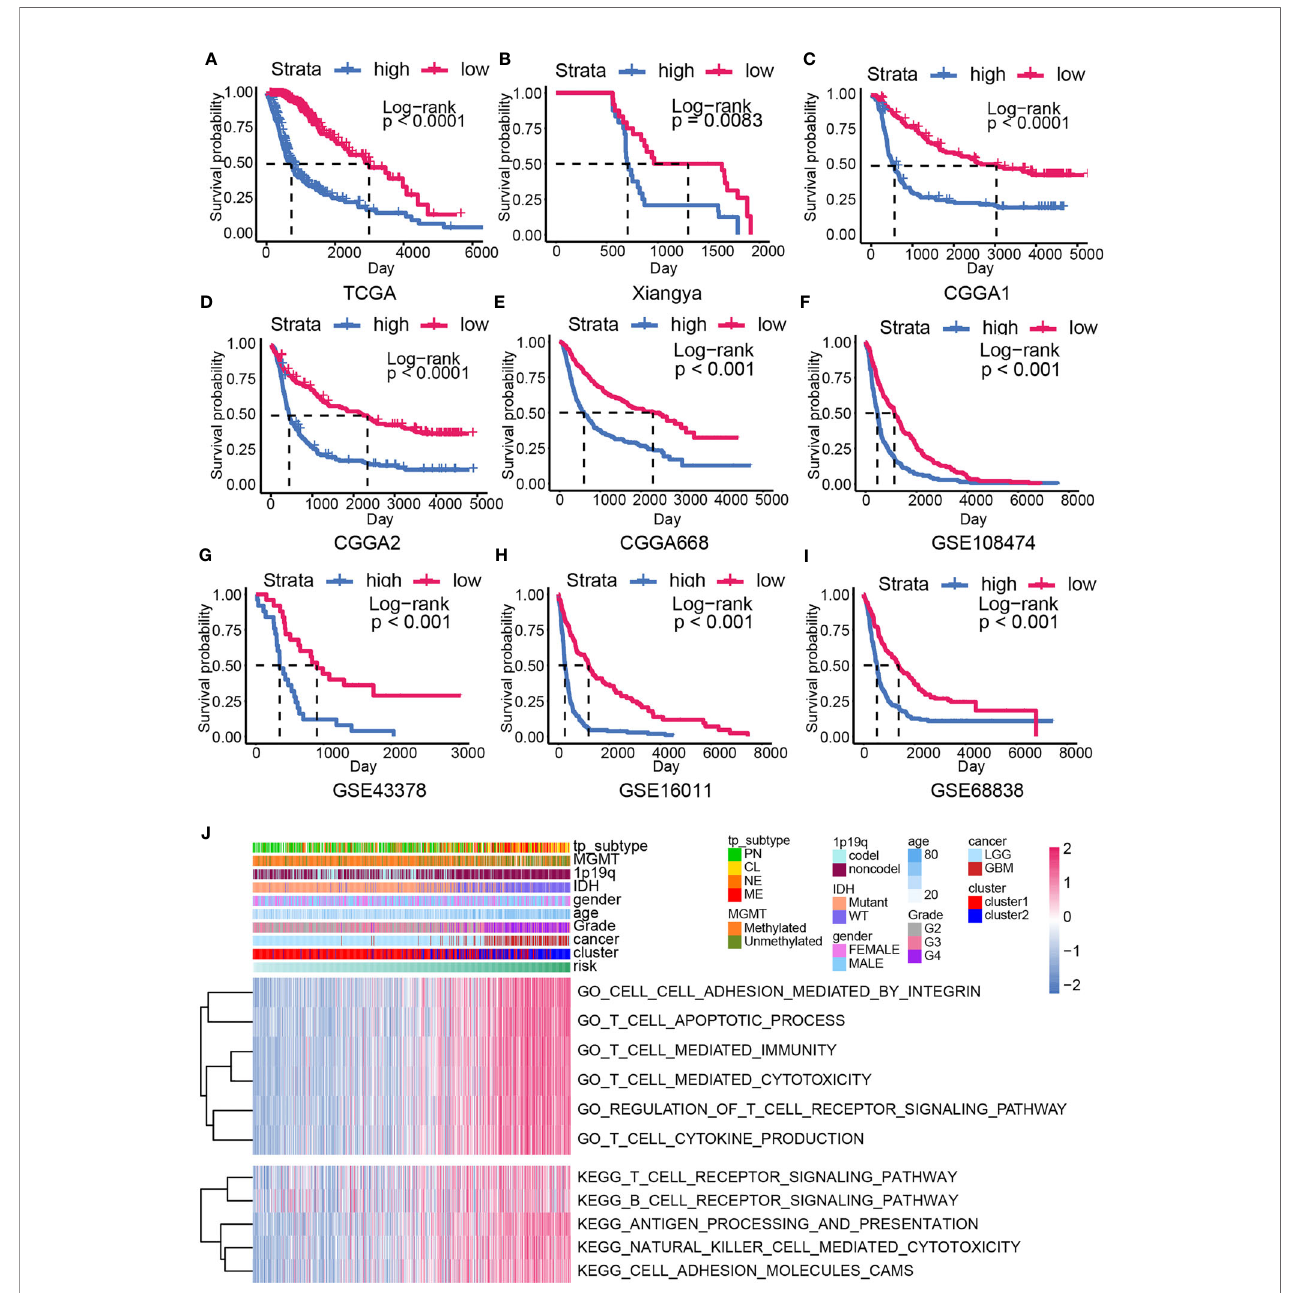
FIGURE 4 | The overall survival analysis and biofunction prediction based on the risk model. Kaplan – Meier survival analysis based on the risk model from the training cohort (A) and the validation cohort, including Xiangya cohort (B) , CGGA1 (C) , CGGA2 (D) , CGGA688 (E) , GSE108474 (F) , GSE43378 (G) , GSE16011 (H) , GSE68838 (I) . (J) GO/KEGG enrichment analysis based on the GSVA analysis in the training